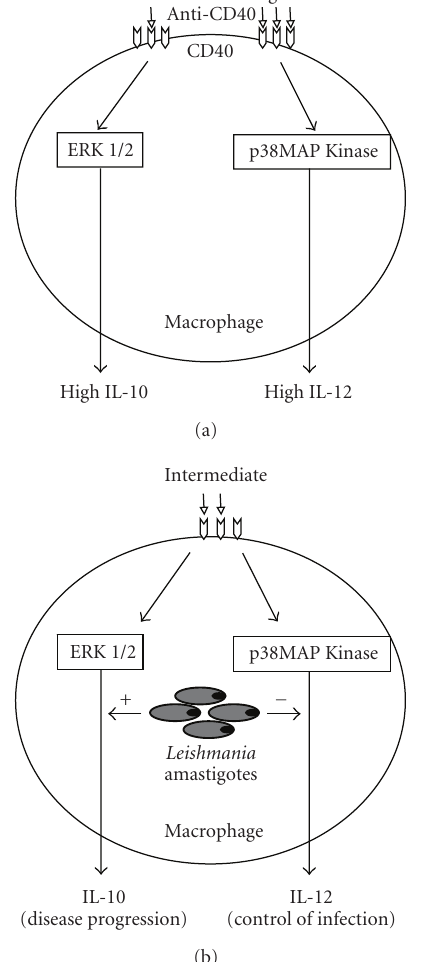
Figure 2: Strength of CD40-CD40L interaction can influence the out- come of parasite infection . (a) Cross-linking of CD40 with lower doses of agonistic anti-CD40 antibody ( < 3 μ g/mL) on noninfected macrophages increases phosphorylation of extracellular stress- related kinase 1/2 (ERK 1/2) and consequently stimulates high production of IL-10, whereas cross-linking with higher doses ( > 3 μ g/mL) increases phosphorylation of p38-mitogen activated pro- tein kinase (p38MAPK) and therefore stimulates high production of IL-12. (b) Cross-linking of Leishmania -infected macrophages with intermediate dose of anti-CD40 antibody (3 μ g/mL) leads to pro- duction of more IL-10 and less IL-12 than uninfected macrophages. This suggests the potential involvement of parasite factors in disease progression through stimulation of IL-10